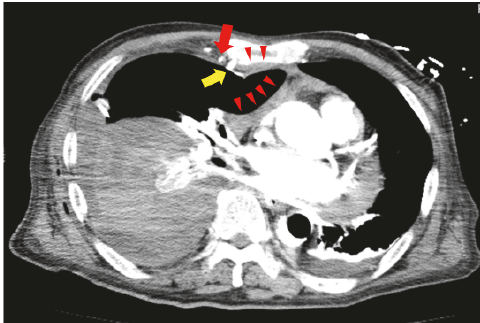
Figure 2: Contrast computed tomography (CT) scan on the next day of hospitalization. Right internal mammary artery (IMA) is divided into branches.A red arrow shows main branch of IMA and a yellow arrow shows the extravasation at a branchof IMA. There is small anterior mediastinal hematoma (red arrowheads) around the extravasation. Massive bloody pleural effusion is confirmed in the right